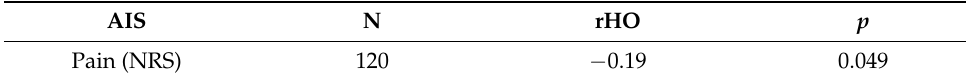
Table 10. Acceptance of illness versus pain intensity.